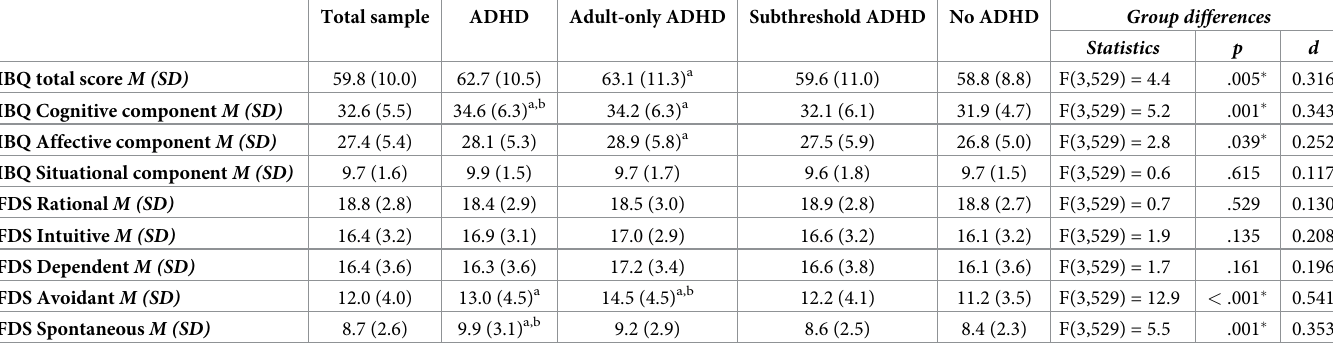
Table 2. Impulsive buying and financial decision styles of total sample and ADHD